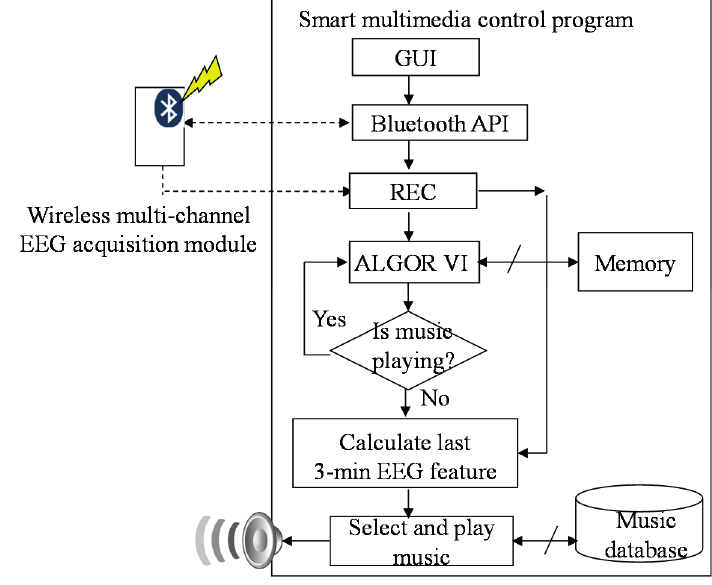
Figure 3. Operation procedure of smart multimedia control